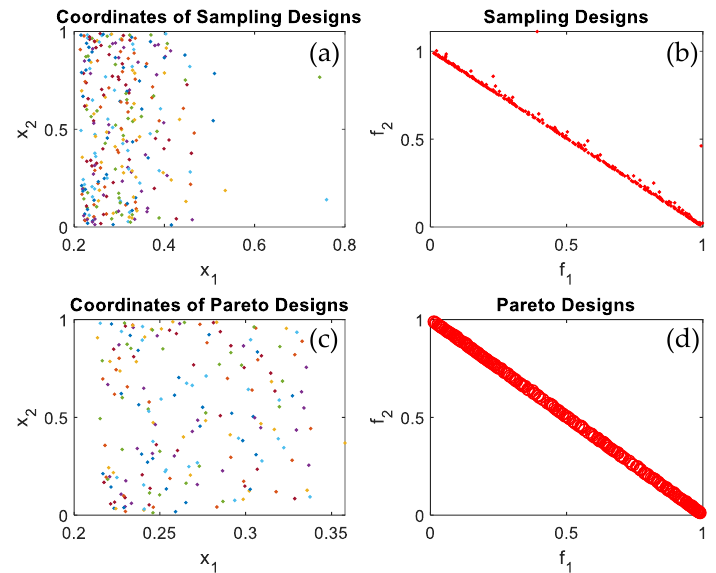
Figure 5. Computational simulations Pareto frontier determination of test function F2 ( a ) coordinates od sampling points; ( b ) sampling points in feasible design space; ( c ) coordinates of Pareto points; ( d ) the seeking Pareto frontier.